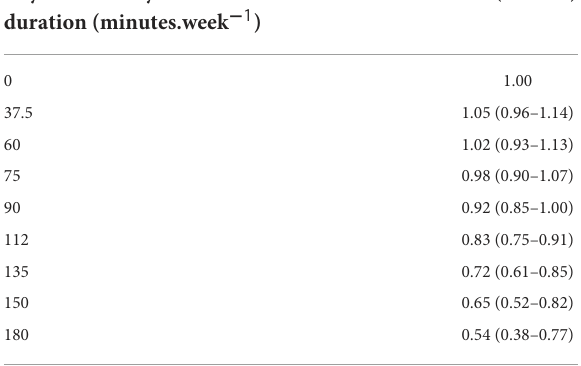
TABLE 2 The does-response analysis of physical activity duration and the risk of postpartum depression.